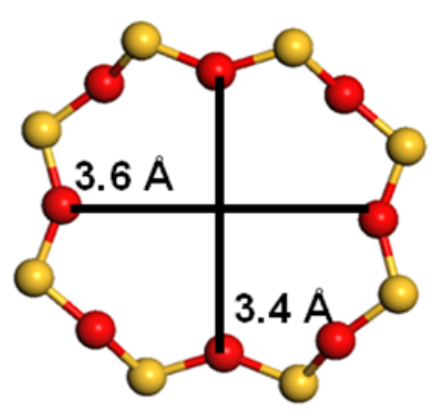
Figure 3. 8-membered oxygen ring in SAPO-56 viewed normal to [001], red spheres - oxygen atoms, yellow spheres - T-atoms